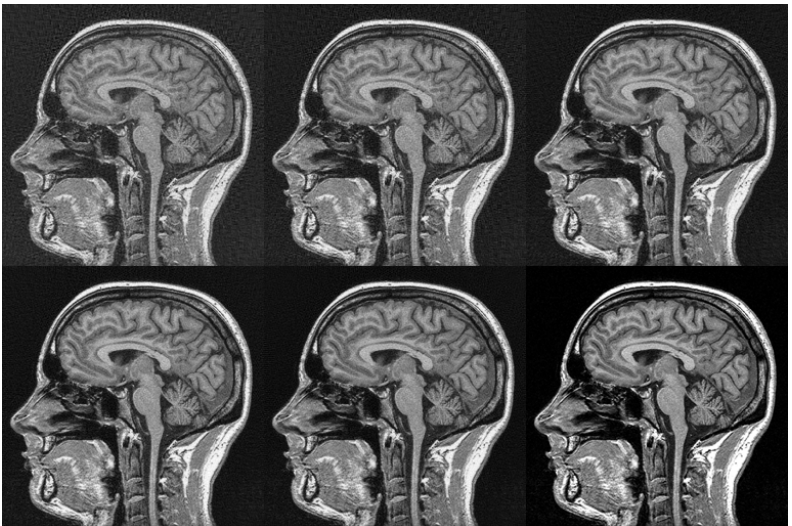
Figure 11. Images reconstructed with fewer than N /4 impulse responses, N = 256. Top row, from left to right, reconstructions for four, eight and sixteen impulse responses per dimension. Bottom row, from left to right, 32 and 64 ( N /4) impulse responses. Then, the original picture to compare with. The obtained PSNR from lesser to greater number of different impulse responses considered are: [24.97, 27.36, 30.98, 32.96, 33.08]